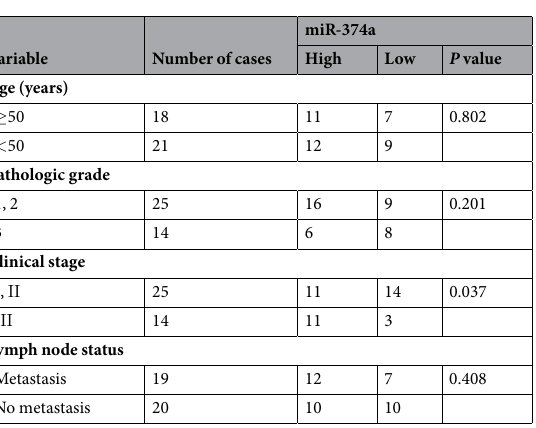
Table 1. Relationship between miR-374a level and clinicopathologic parameters of breast